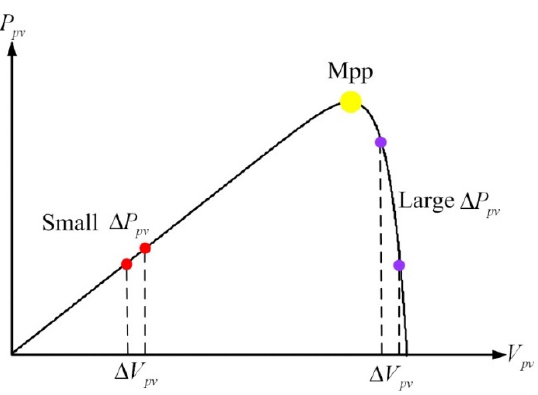
Figure 6. Concept for designing MF setting values of asymmetrical FLC-based